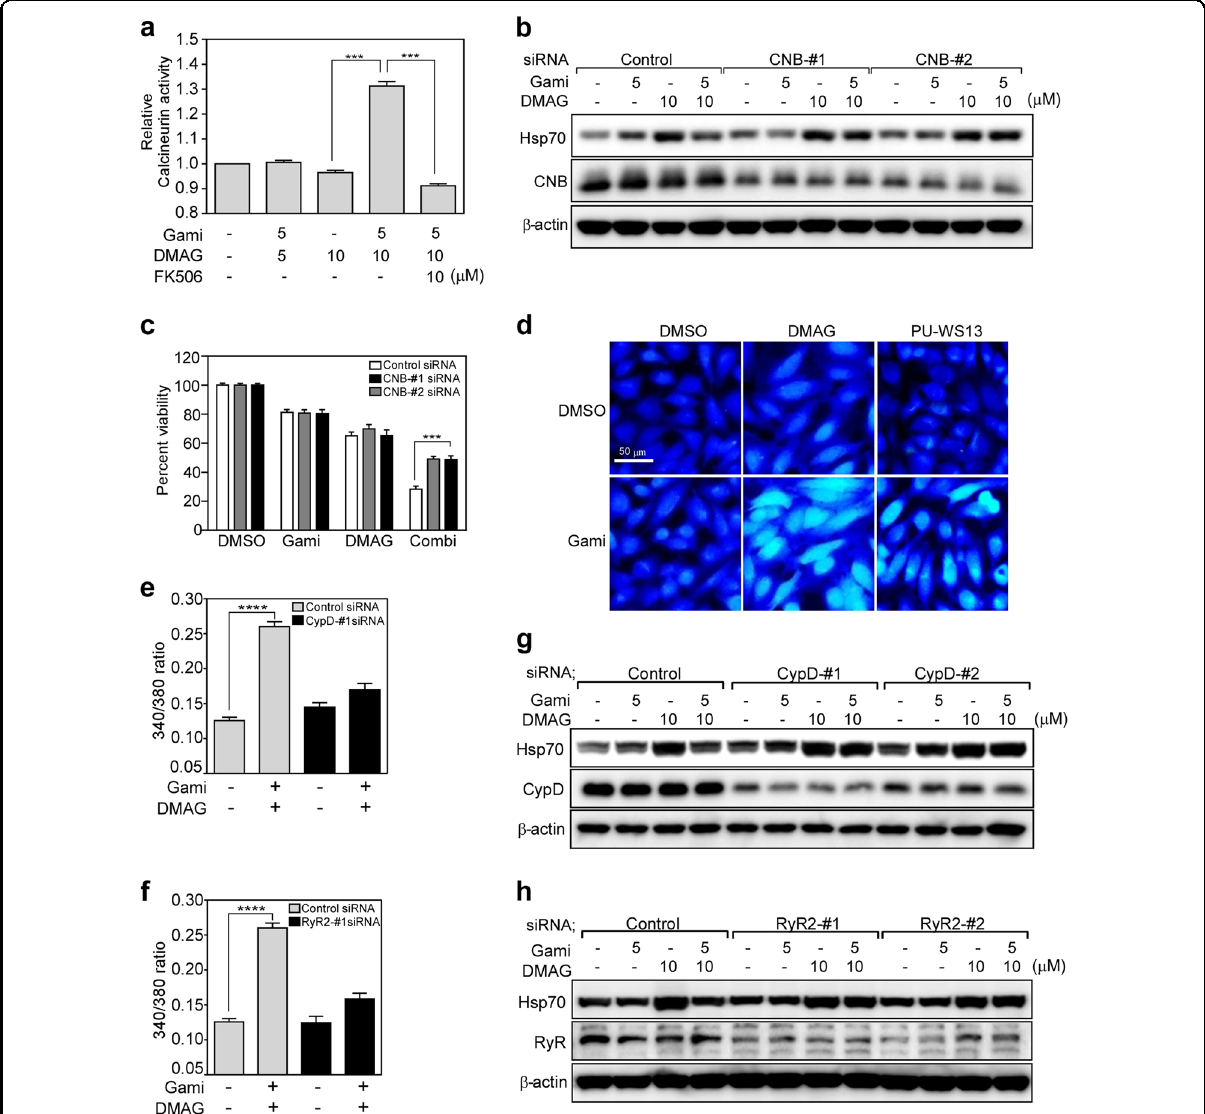
Fig. 4 Drug-induced calcium-dependent calcineurin activity promotes cell death. a Calcineurin activity. HeLa cells were treated with drugs for 6 h. Calcineurin activity in total cell extracts was analyzed using a calcineurin phosphatase assay kit. Activity was expressed relative to that in DMSO- treated controls. b Suppression of Hsp70 by calcineurin silencing. Cells were treated for 24 h with control or calcineurin regulatory subunit (CNB) siRNAs, incubated for 6 h with drugs, and then analyzed by western blotting. c Effects of combined drug treatment in the absence of CNB. Cells